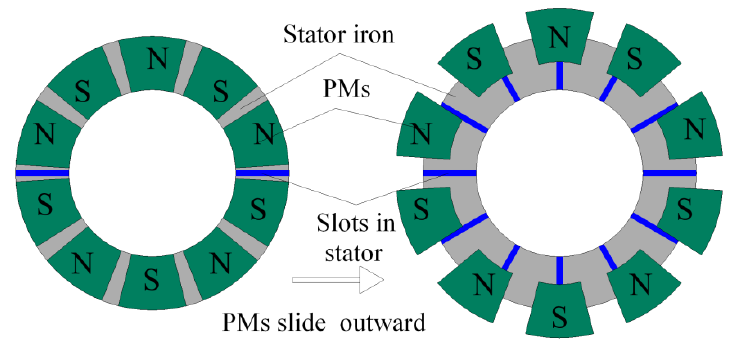
Figure 1. Schematic diagram of the field weakening principle using radially sliding permanent magnets